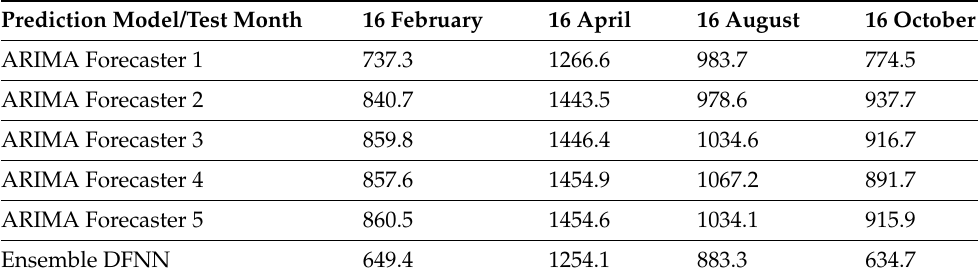
Table 2. One day-ahead NE Load Forecasting results: RMSE